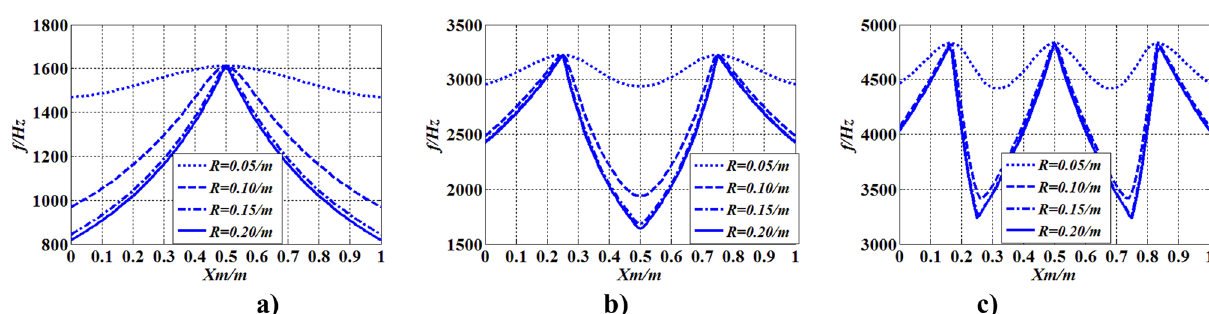
Figure 13. The lowest six natural frequencies of the FF shaft carrying one moving concentrated inertia.